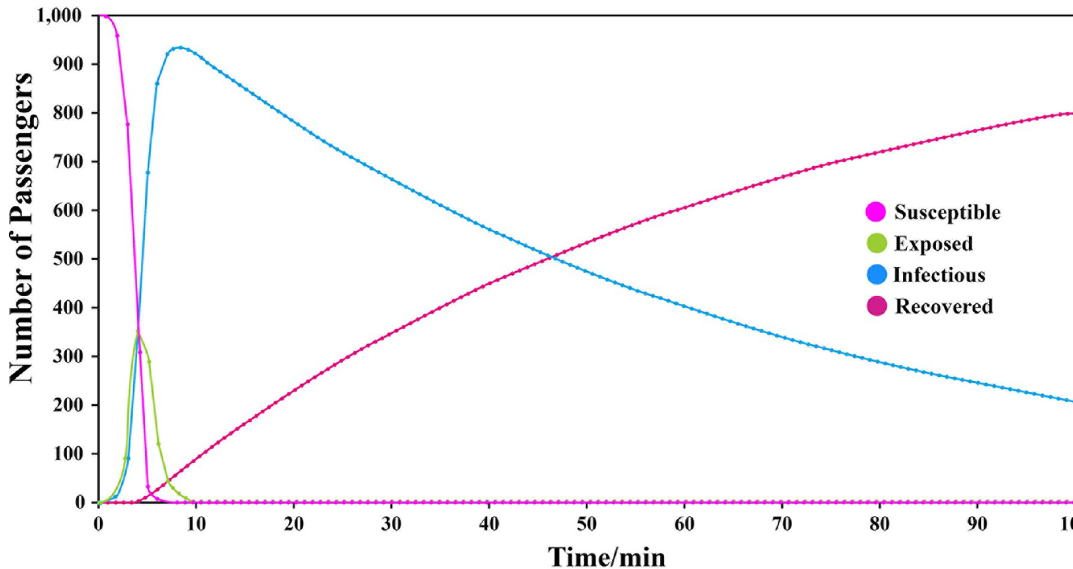
Fig 9. The population dynamics of different